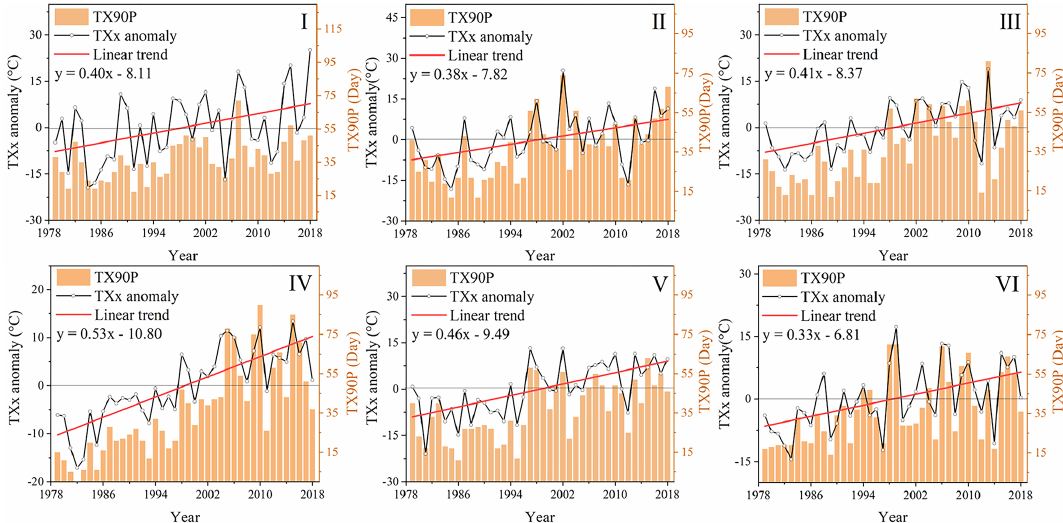
Figure 12. Multi-axis diagram of TXx anomaly, TX90p, and T max linear trend graphs. The broken black line represents the TXx anomaly, the red line represents the linear regression of the TXx anomaly, and the orange histogram represents the TX90p change trend.